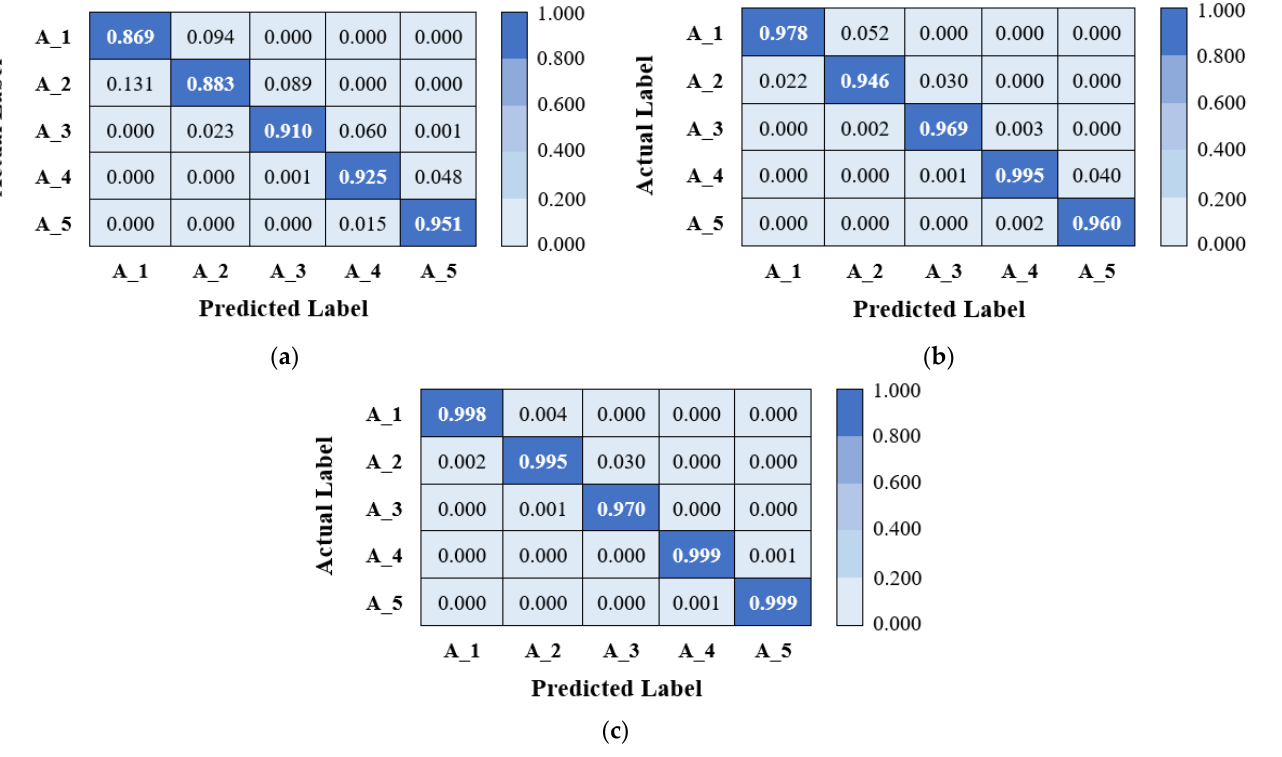
Figure 13. Confusion matrix for 20°/25° tooth pro fi le: ( a ) SNR = 5; ( b ) SNR = 10; ( c ) SNR = 15.